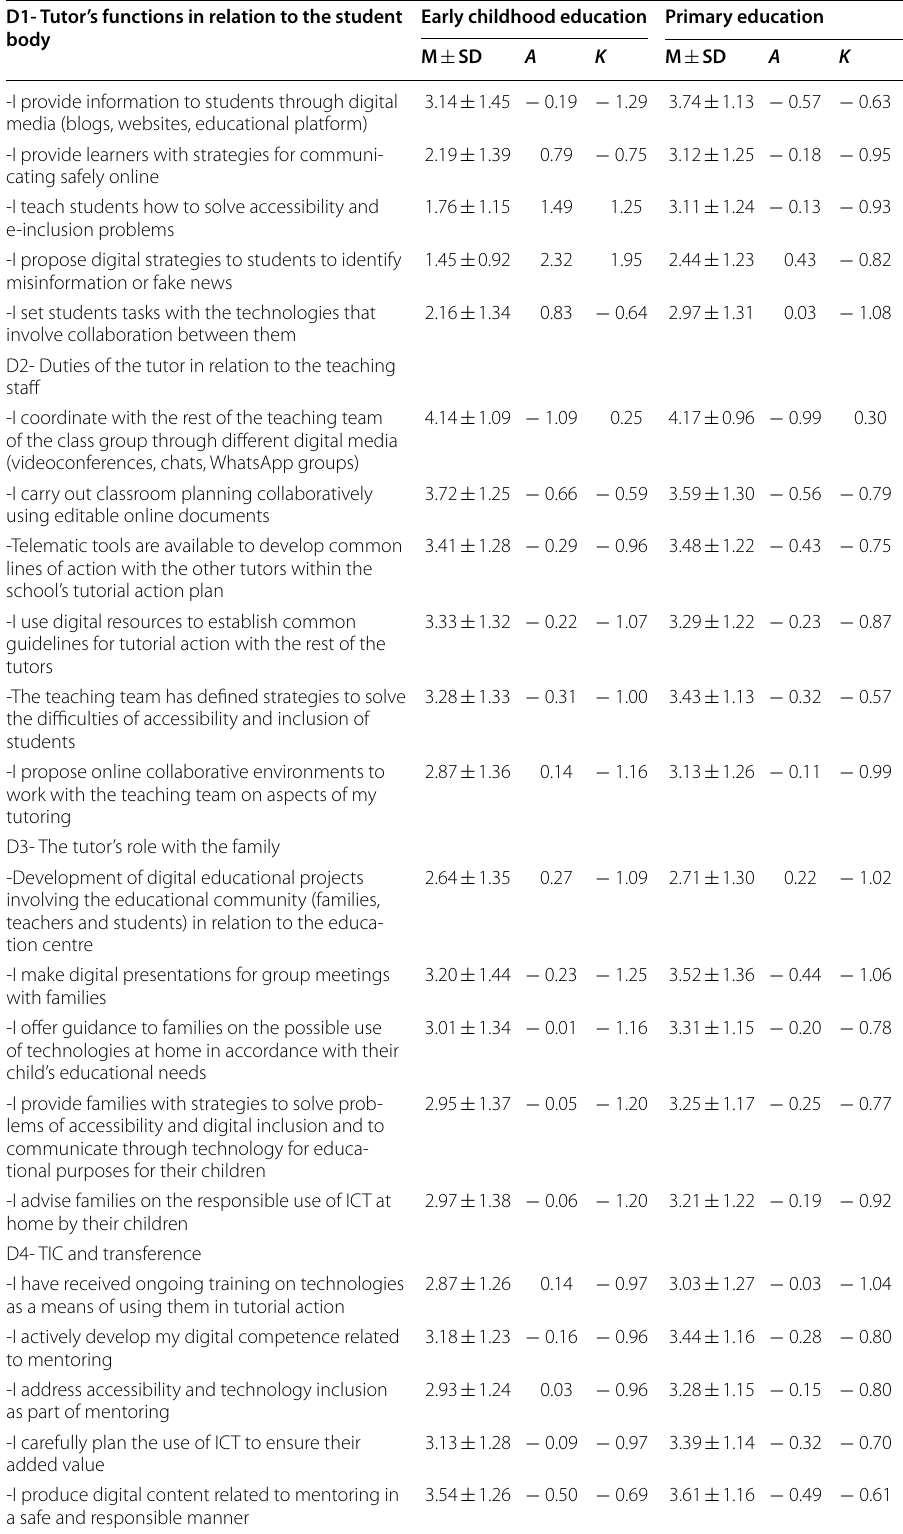
Table 4 Descriptive analysis according to education